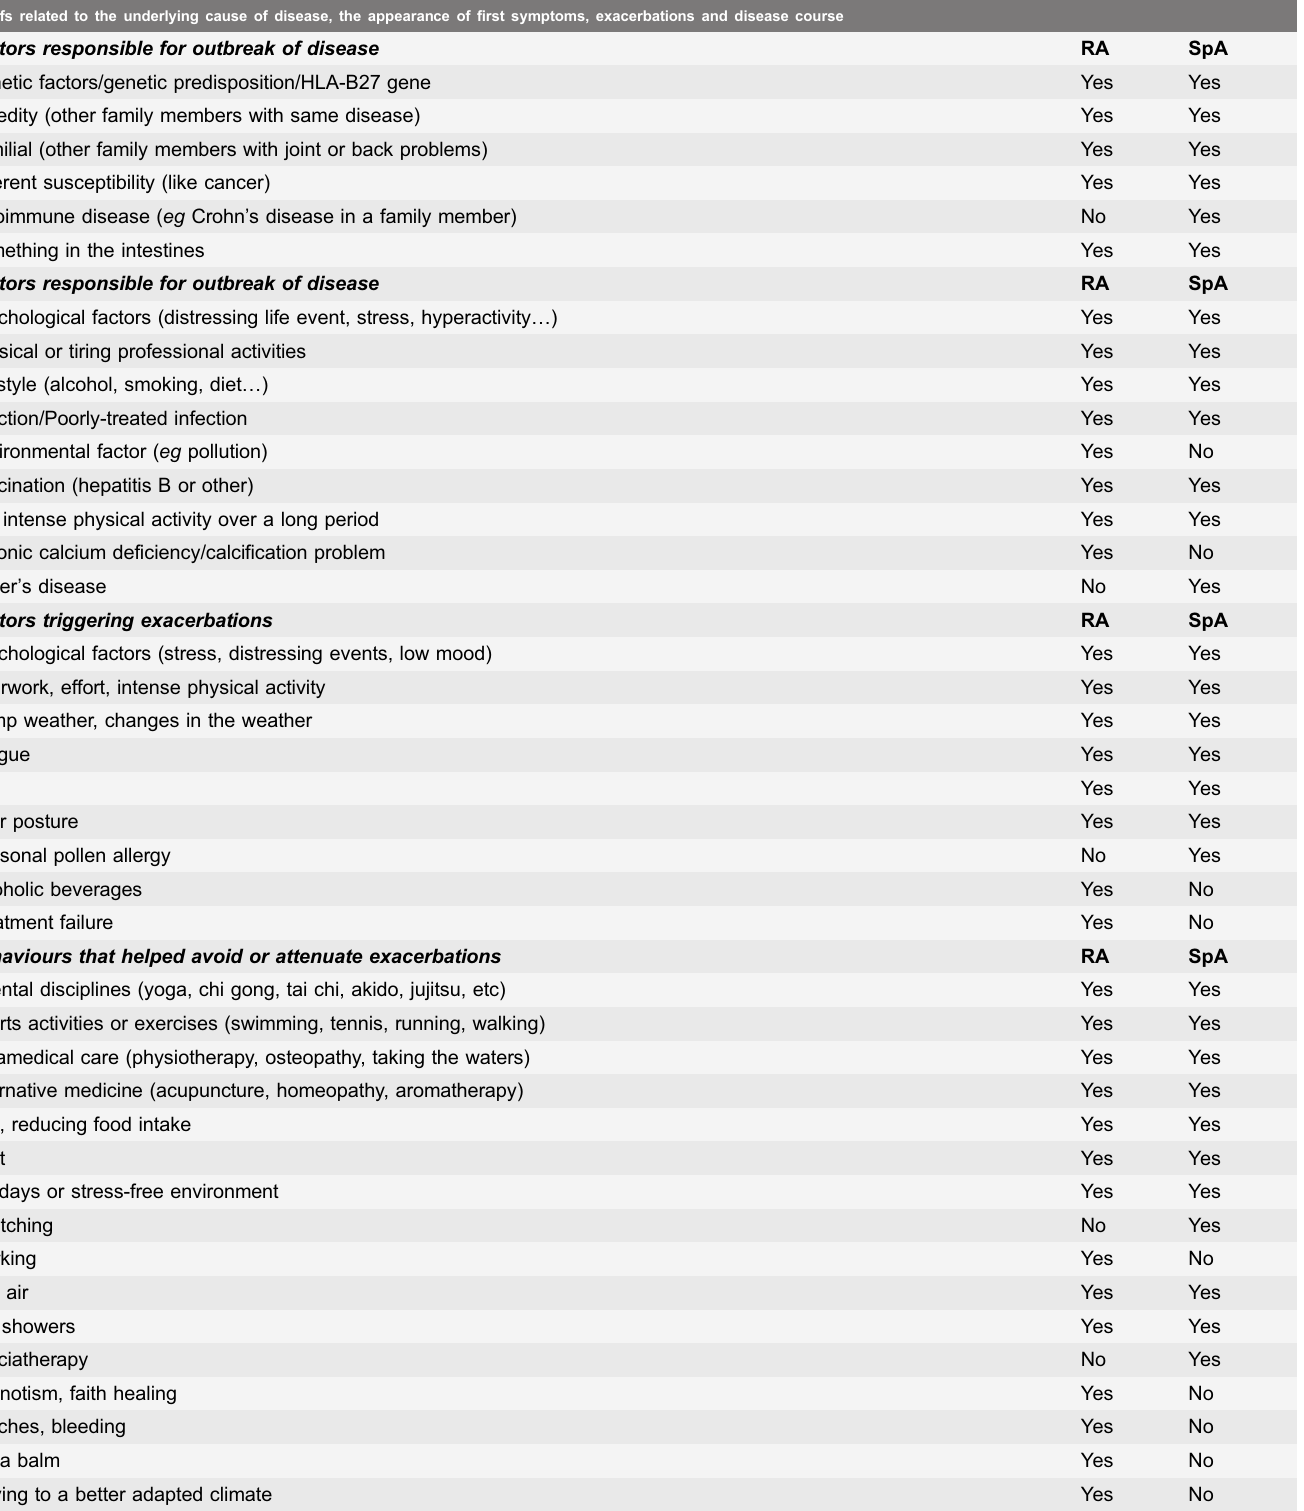
Table 2. Beliefs, fears and attitudes identified in the